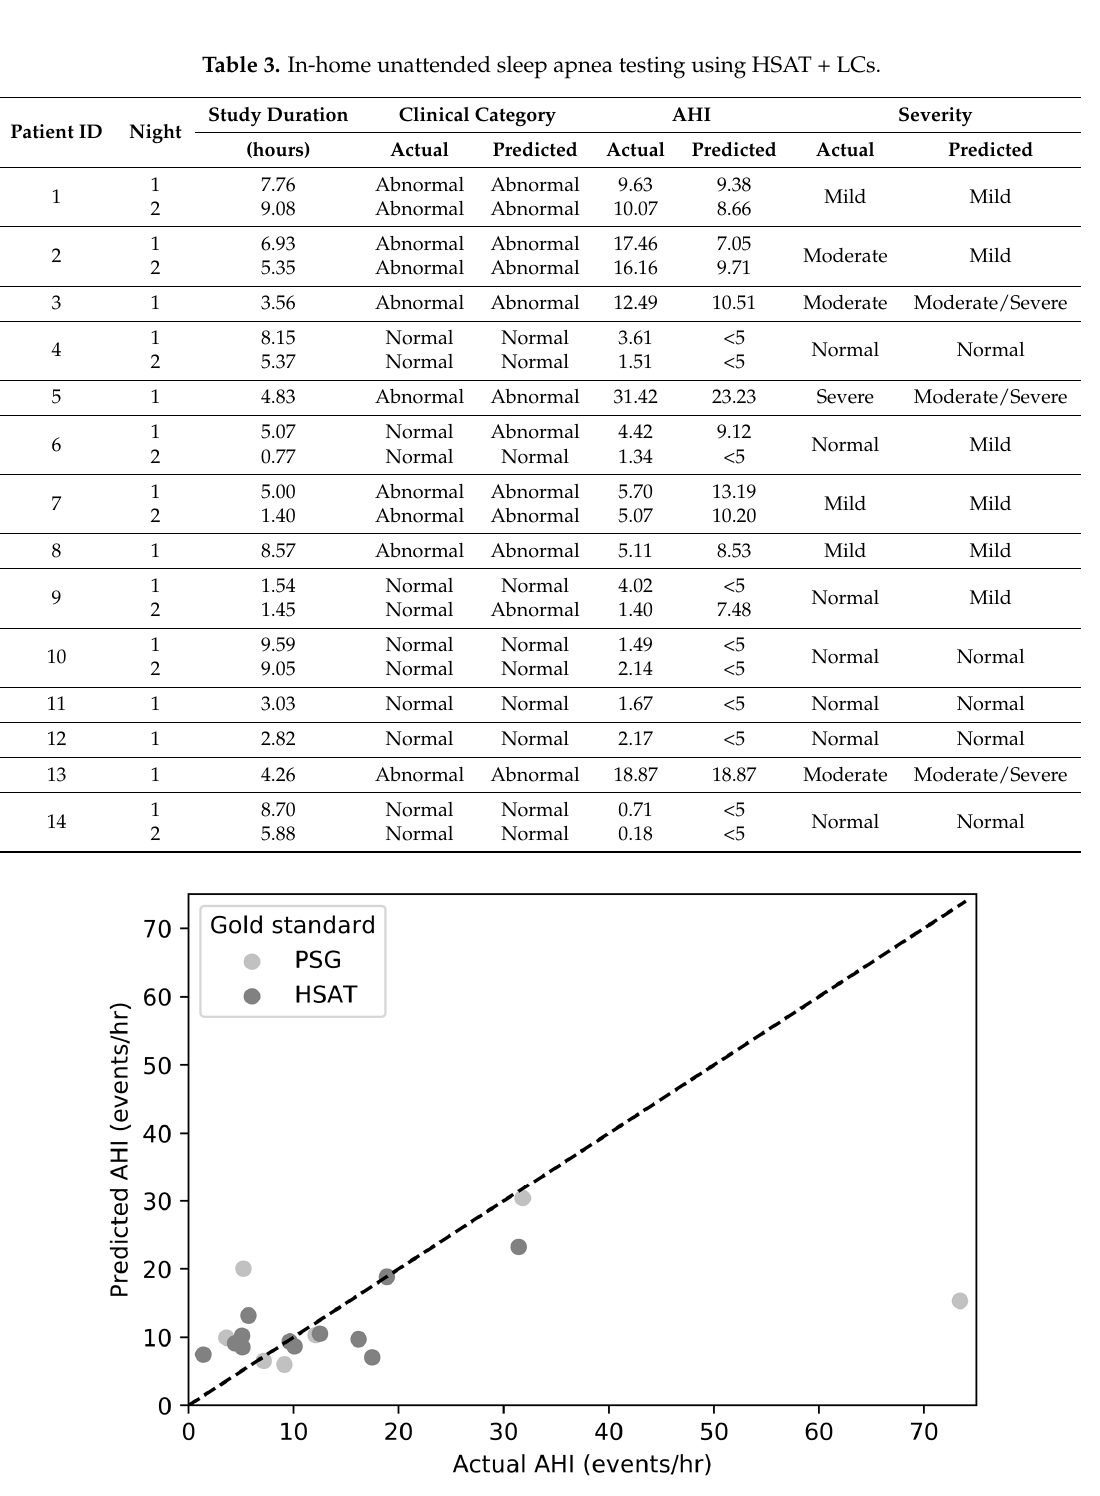
Figure 6. Actual AHI versus predicted AHI. Pearson’s R = 0.47 (polysomnography (PSG) vs. LC: R = 0.37, home sleep apnea test (HSAT) vs. LC: R =